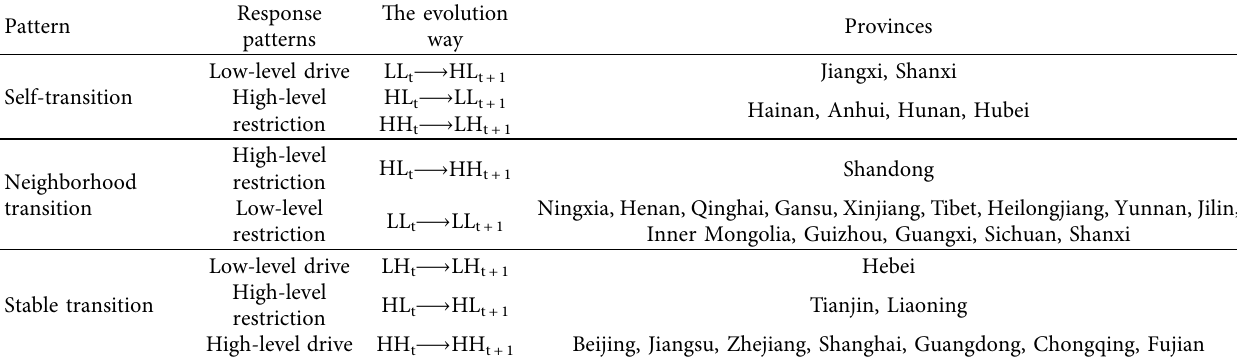
Table 5: China’s construction industry development spatiotemporal response